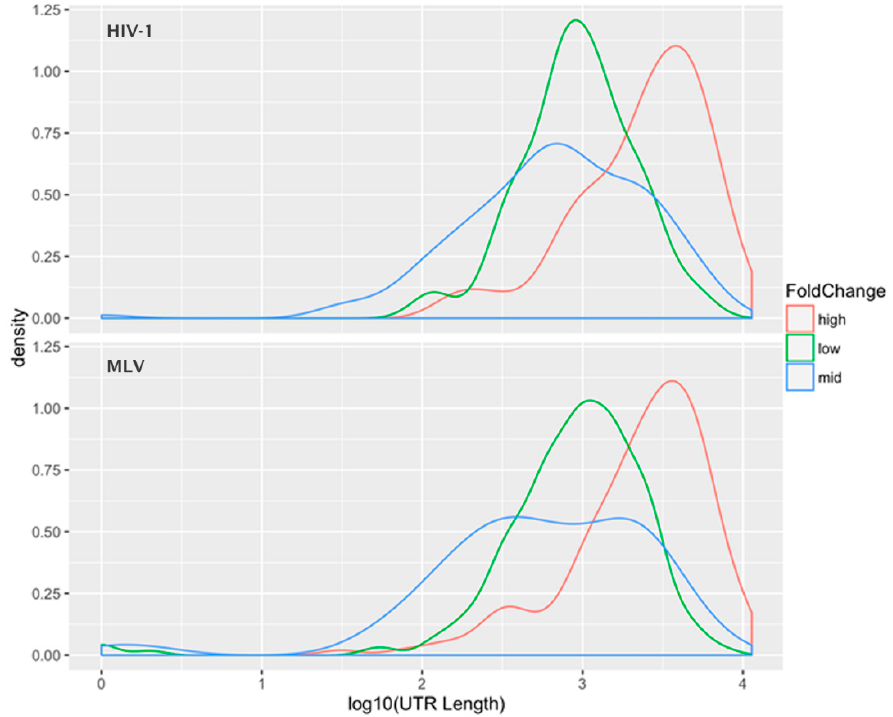
Figure 3. Preferential encapsidation of messenger RNA (mRNA) molecules with long 3’ UTRs. The log fold changes between messenger RNA (mRNA) measurements in the cellular and viral components were divided into groups of 1000 genes. The 1000 most excluded RNA species, labeled low; an “average” group representing the middle 1000 genes; and the 1000 most enriched mRNAs, the “high” group, are represented by different colored density plots. The plot depicts the log 10 (UTR length) on the x ‐ axis and the density on the y ‐ axis. Upper panel: HIV ‐ 1; lower panel, MLV.